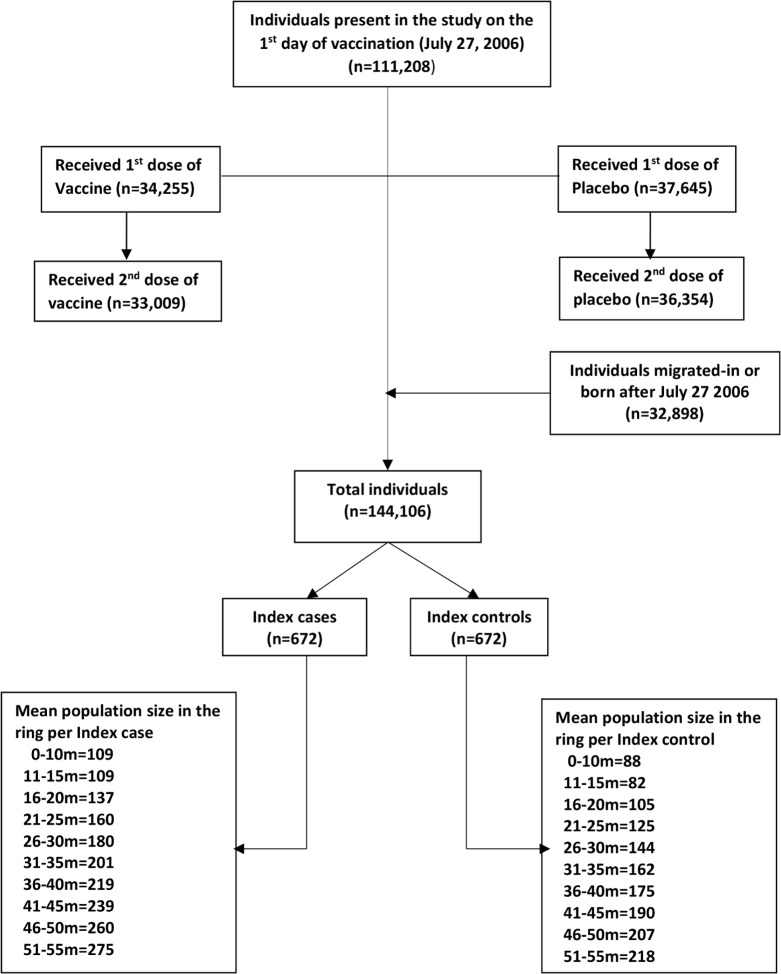
CONSORT flow chart for assembling the population.The ring 0–10 m includes individuals living 0.00 m to 10.00 m from the index case/control, the ring 11–15 m includes individuals living 10.01 m to 15.00 m from the index case/control, and so on.